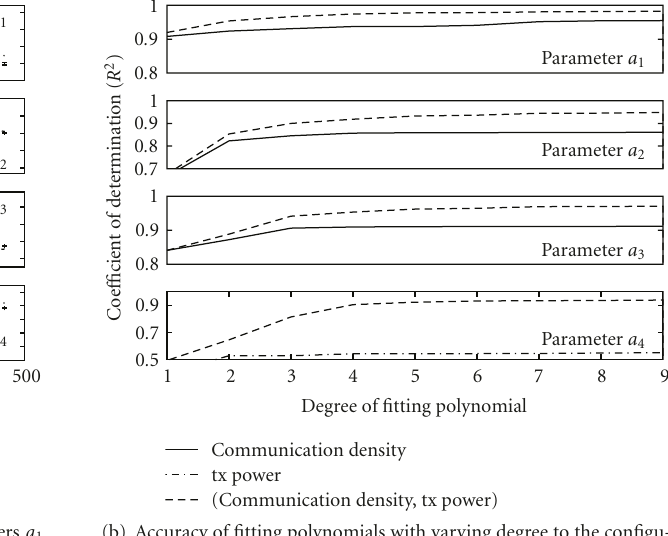
(a) Curve fit of a polynomial (fourth degree) to fitting parameters a 1 (b) Accuracy of fitting polynomials with varying degree to the configu- through a 4 based on the communication density ξ . a 4 in particular ration parameter a 1 through a 4 shows considerable deviations from the fitted curve Figure 4: Approximating configuration parameters a 1 through a 4